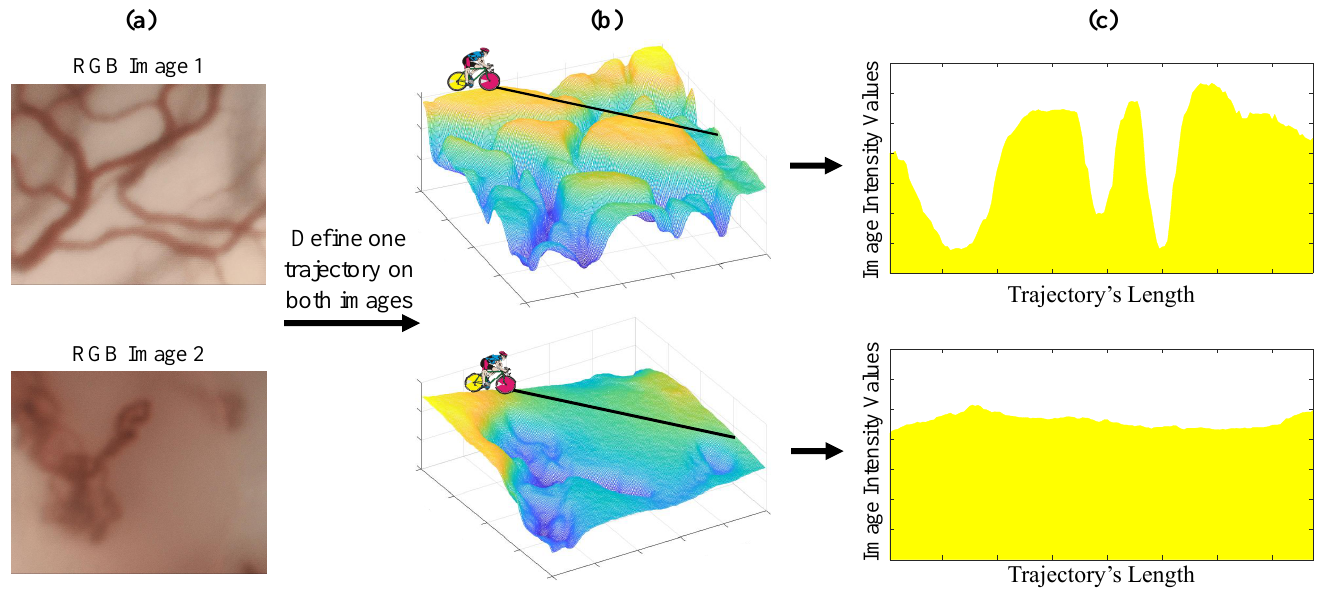
Figure 1. ( a ): RGB 2D image. ( b ): 3D representation of image. ( c ) Stage profile of similar trajectory on two